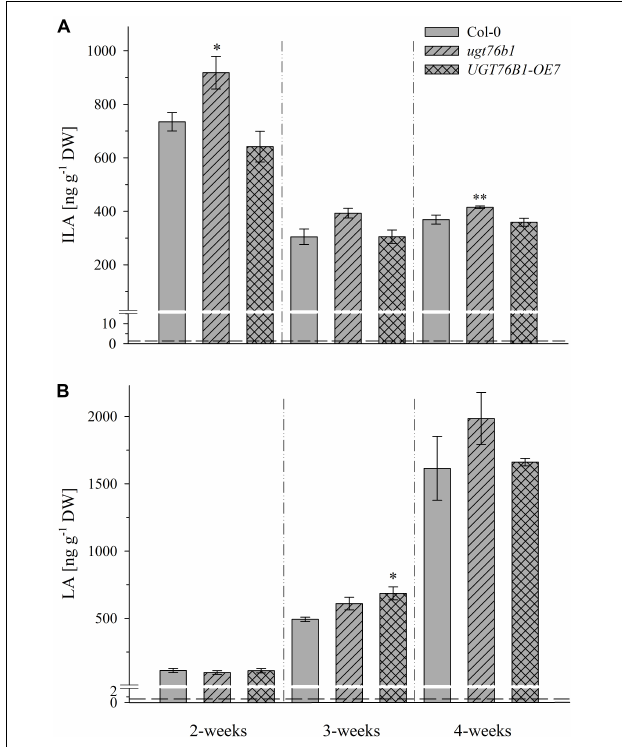
FIGURE 4 | Isoleucic acid and LA abundance in different developmental stages. Levels of (A) ILA and (B) LA in leaves of 2-, 3-, and 4-week-old plants ( Arabidopsis thaliana wild-type [Col-0], ugt76b1-1 and UGT76B1-OE7 ). Plants were grown on soil under short-day conditions (10 h photoperiod). Means ± SE ( n = 4) are plotted. Asterisks indicate statistically significant differences in comparison to wild type (Col-0) ( ANOVA ), ∗ p -value < 0.05, ∗∗ p -value < 0.01. Dashed lines indicate the limit of detection (see section “Materials and Methods”).